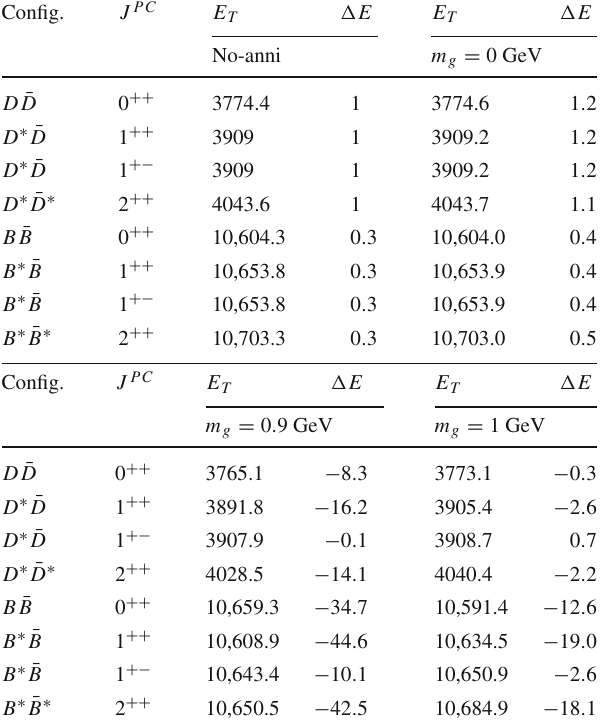
Table 5 Energies (in MeV) of S -wave D ( ∗ ) ¯ D ( ∗ ) and B ( ∗ ) ¯ B ( ∗ ) for the ChQM. ‘No-anni’ means without annihilation interaction